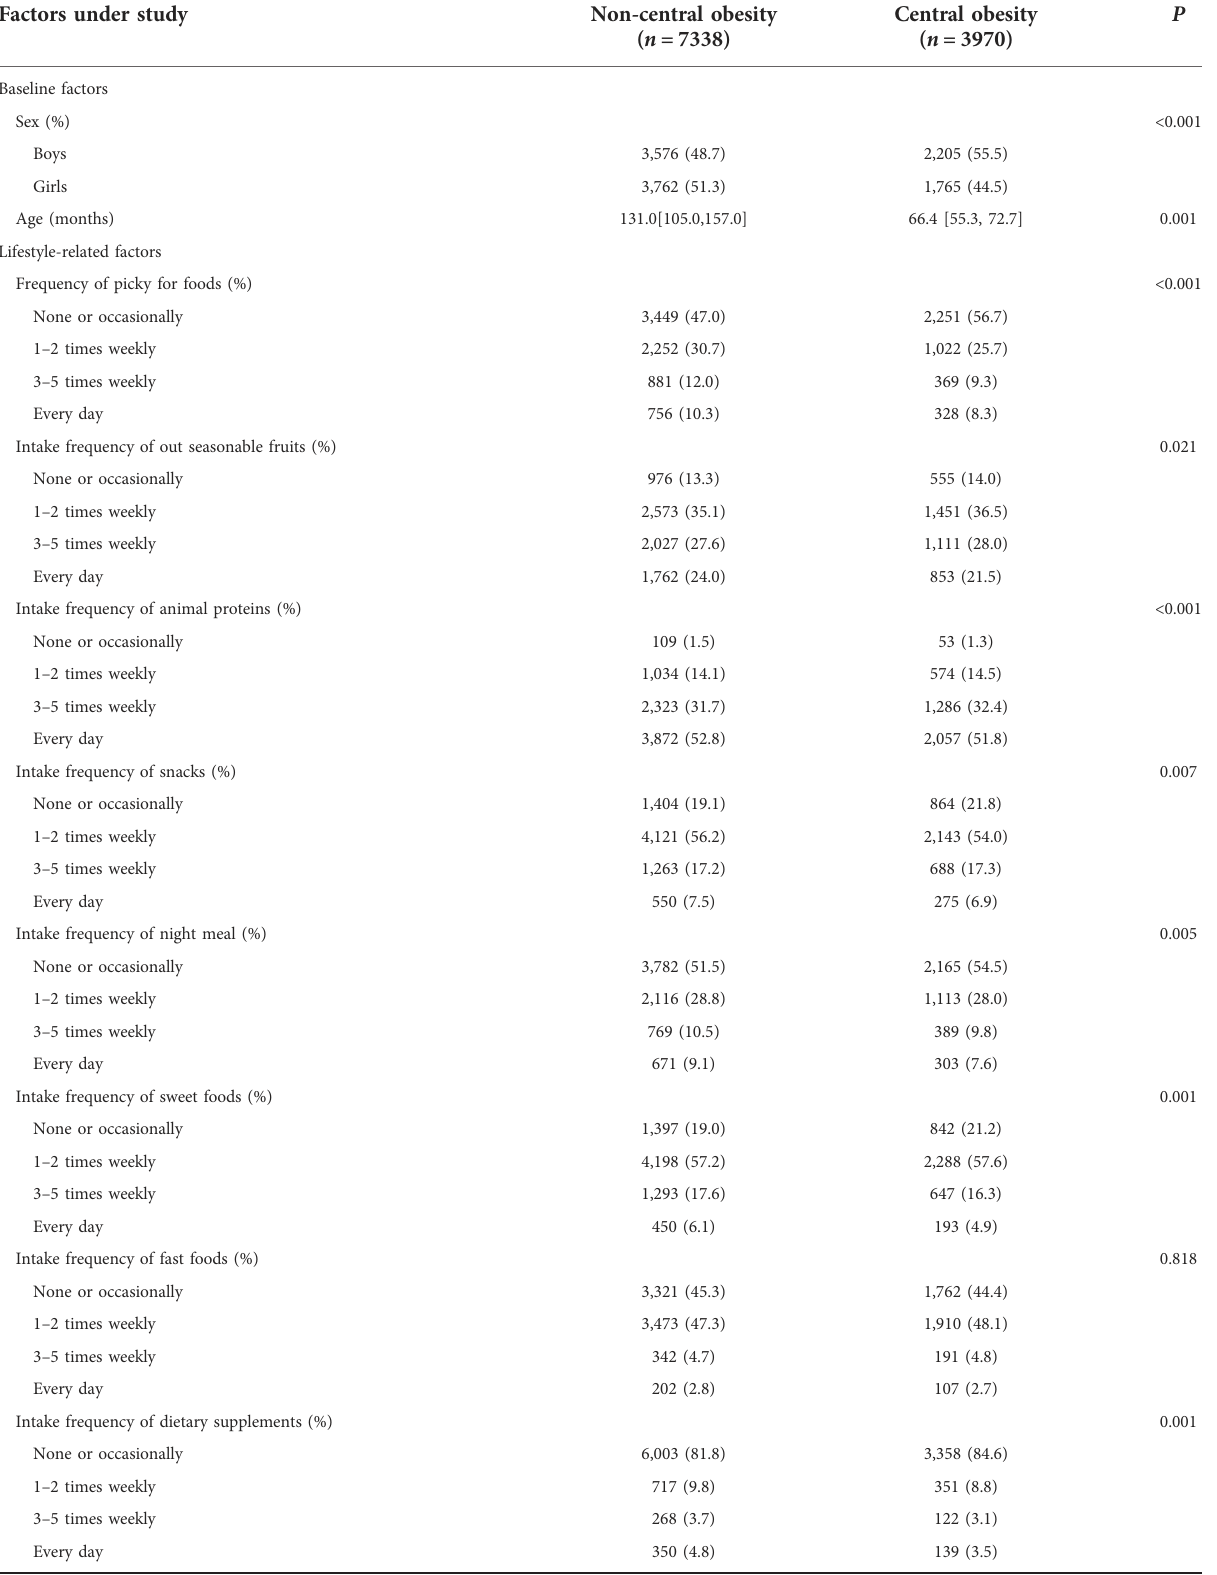
TABLE 1 The baseline characteristics of school students by the presence or absence of central